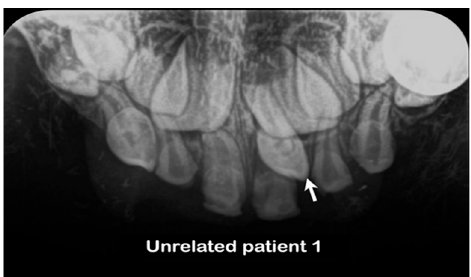
Figure 5. Periapical radiograph of mesiodens of the unrelated patient 1 (arrow).